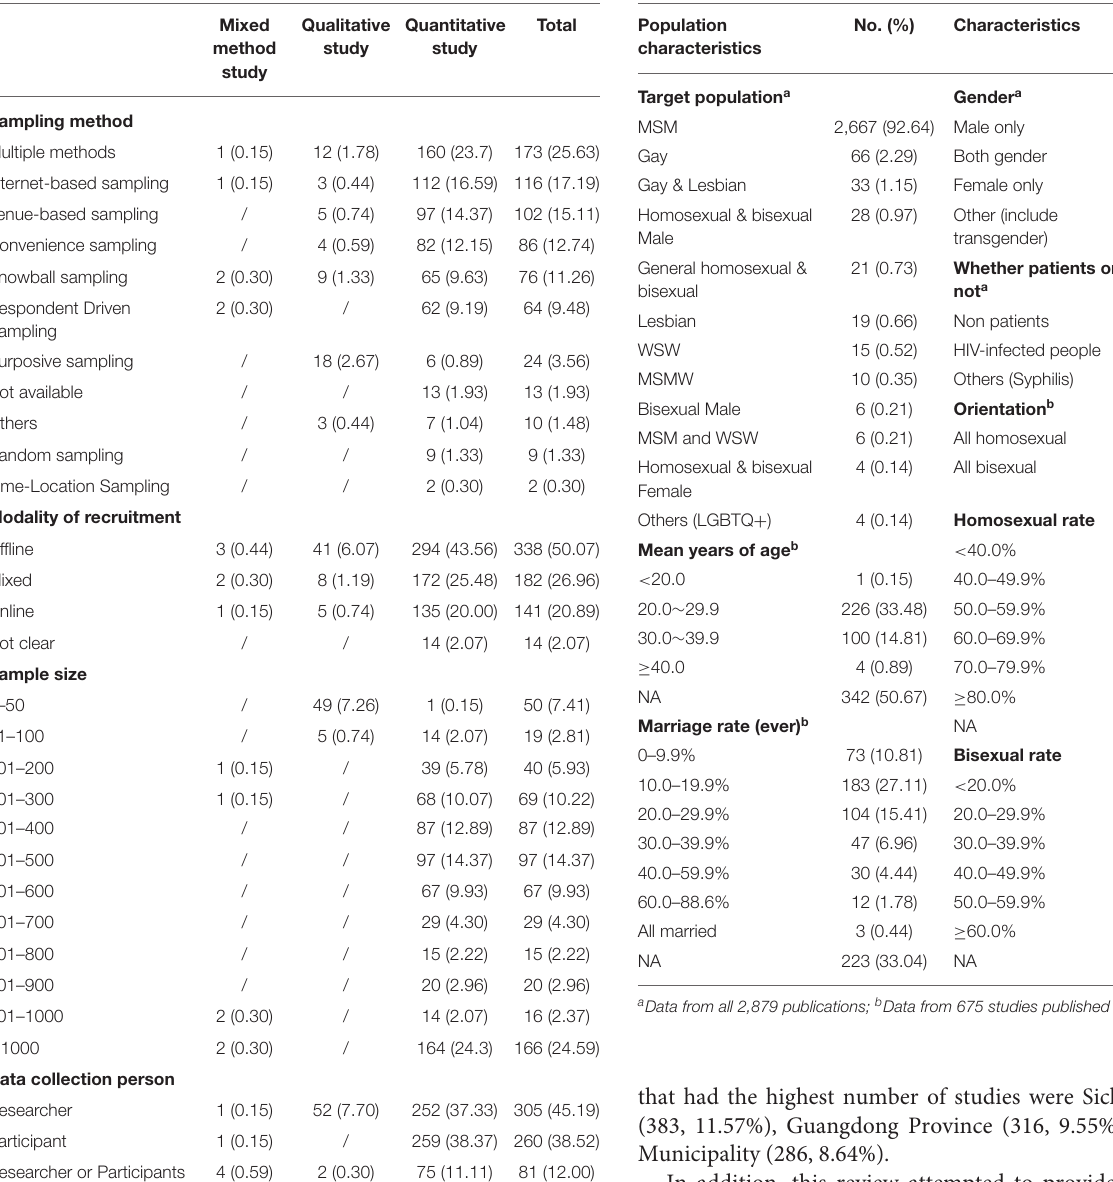
TABLE 3 | Study and sampling characteristics of included EN studies. TABLE 4 | Population characteristics of all included